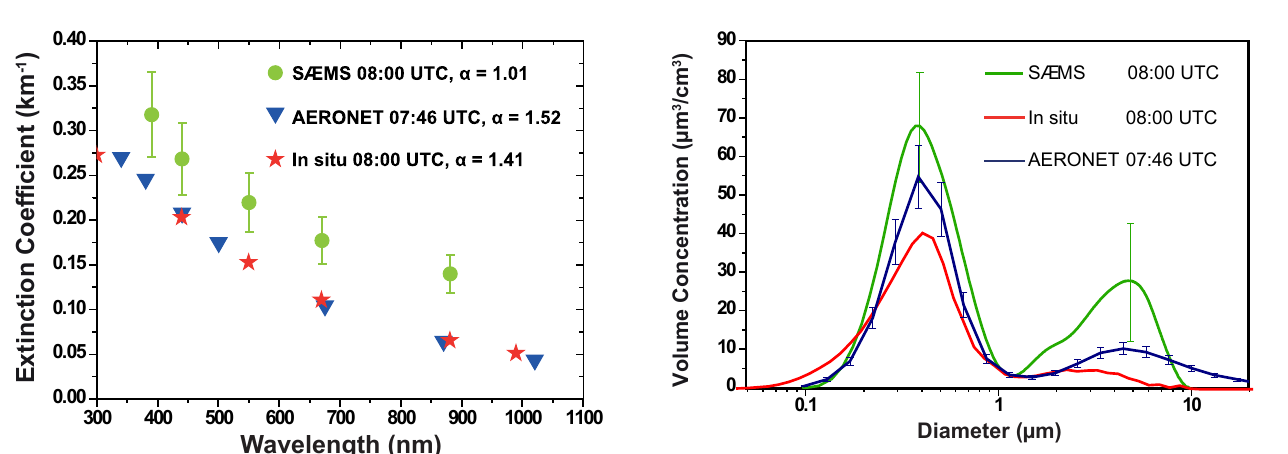
Fig. 9. Spectral particle extinction coefficient measured with SÆMS on the morning of 3 May 2009 (green circles). For comparison, AERONET-derived spectral AOD shown as vertical mean for the 3km tropospheric aerosol layer (blue triangles) and extinction co- efficients computed from in situ-measured particle size distribu- tions (red stars, dry aerosol particles) are shown. The corresponding Ångström exponents α (400–900nm) are also specified.